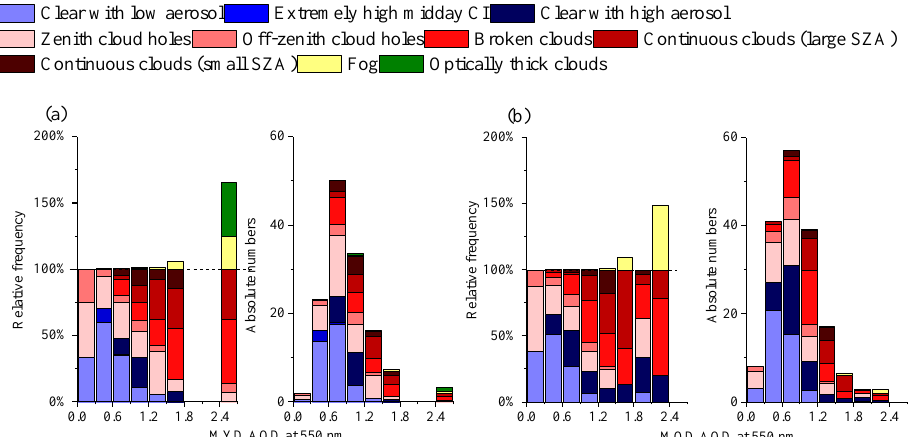
Figure 15. Results of the cloud classification scheme as a function of the aerosol optical depth (AOD) at 550nm from MODIS on Aqua (MYD) (a) and on Terra (MOD) (b) . The left parts of the figures present the relative frequencies of the different sky conditions (see